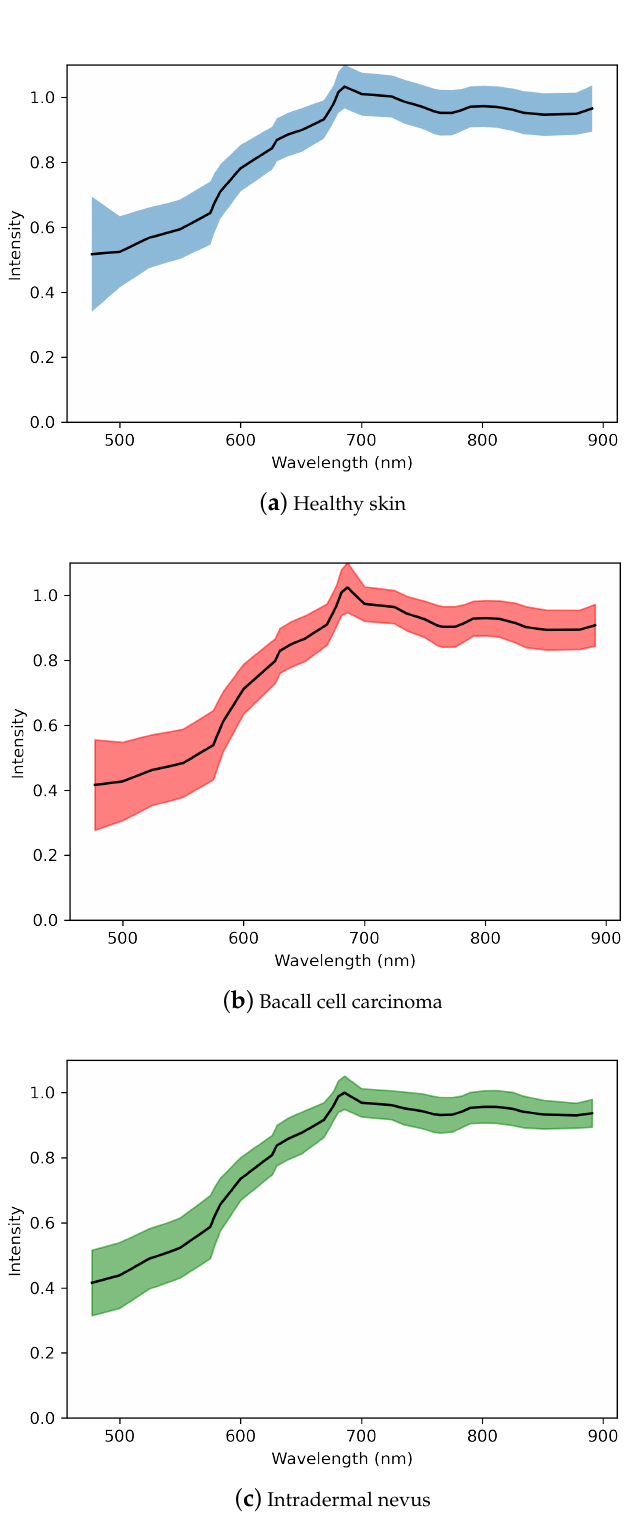
Figure 15. Sub figures ( a – c ) represent the albedo spectra of healthy skin ( a ), BCC ( b ) and ID ( c ). The minimum and maximum standard deviations are marked with coloured areas, and the mean albedo spectra are drawn with a black